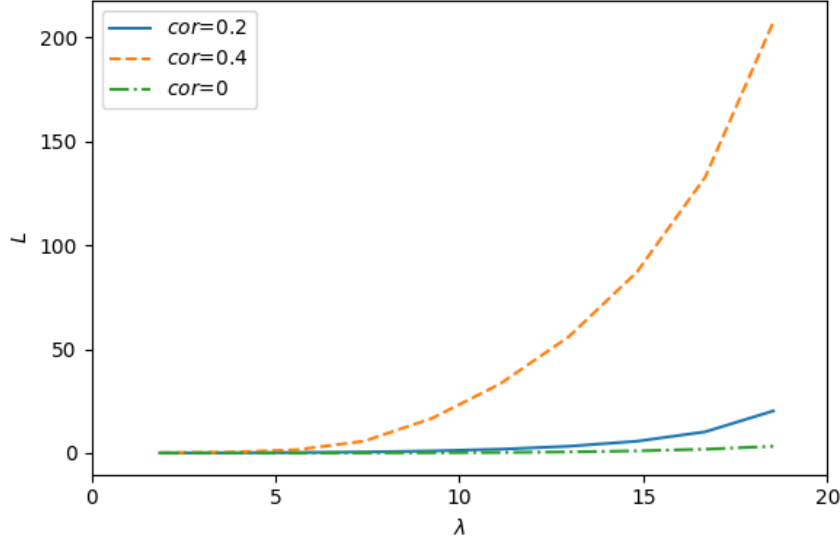
Figure 6. L vs. λ for BMAP s with different coefficients of